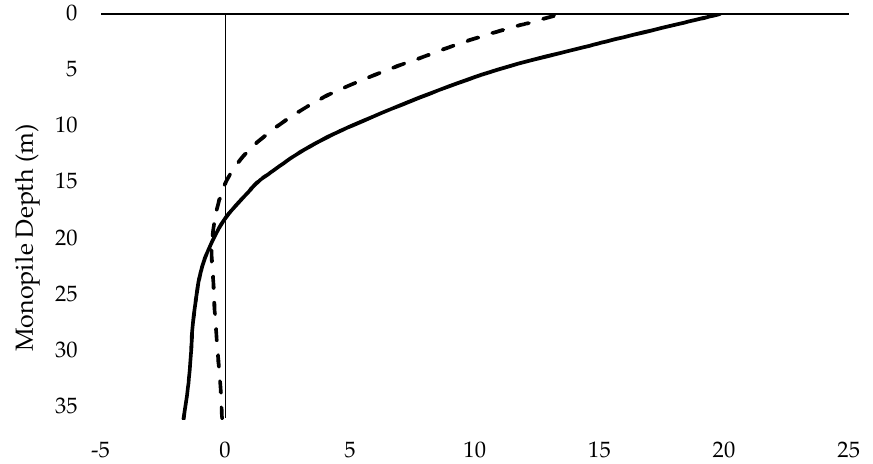
Figure 17. Reaction forces registered for: Pt 0 model (left); and OC 0 model (right).